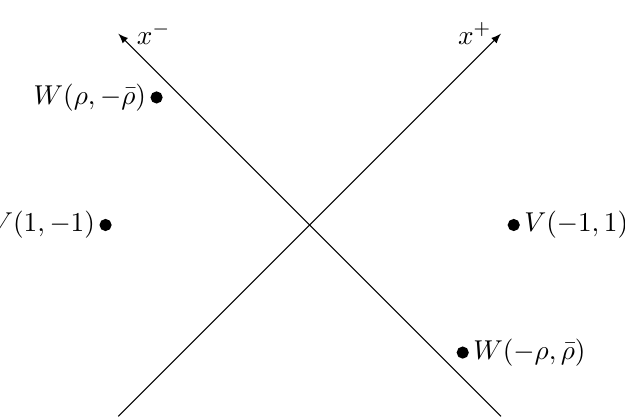
Figure 5 . A Lorentzian four-point function where all points are restricted to a 2 d subspace { x 0 , x 1 } . Null coordinates are defined as x ± = x 0 ± x 1